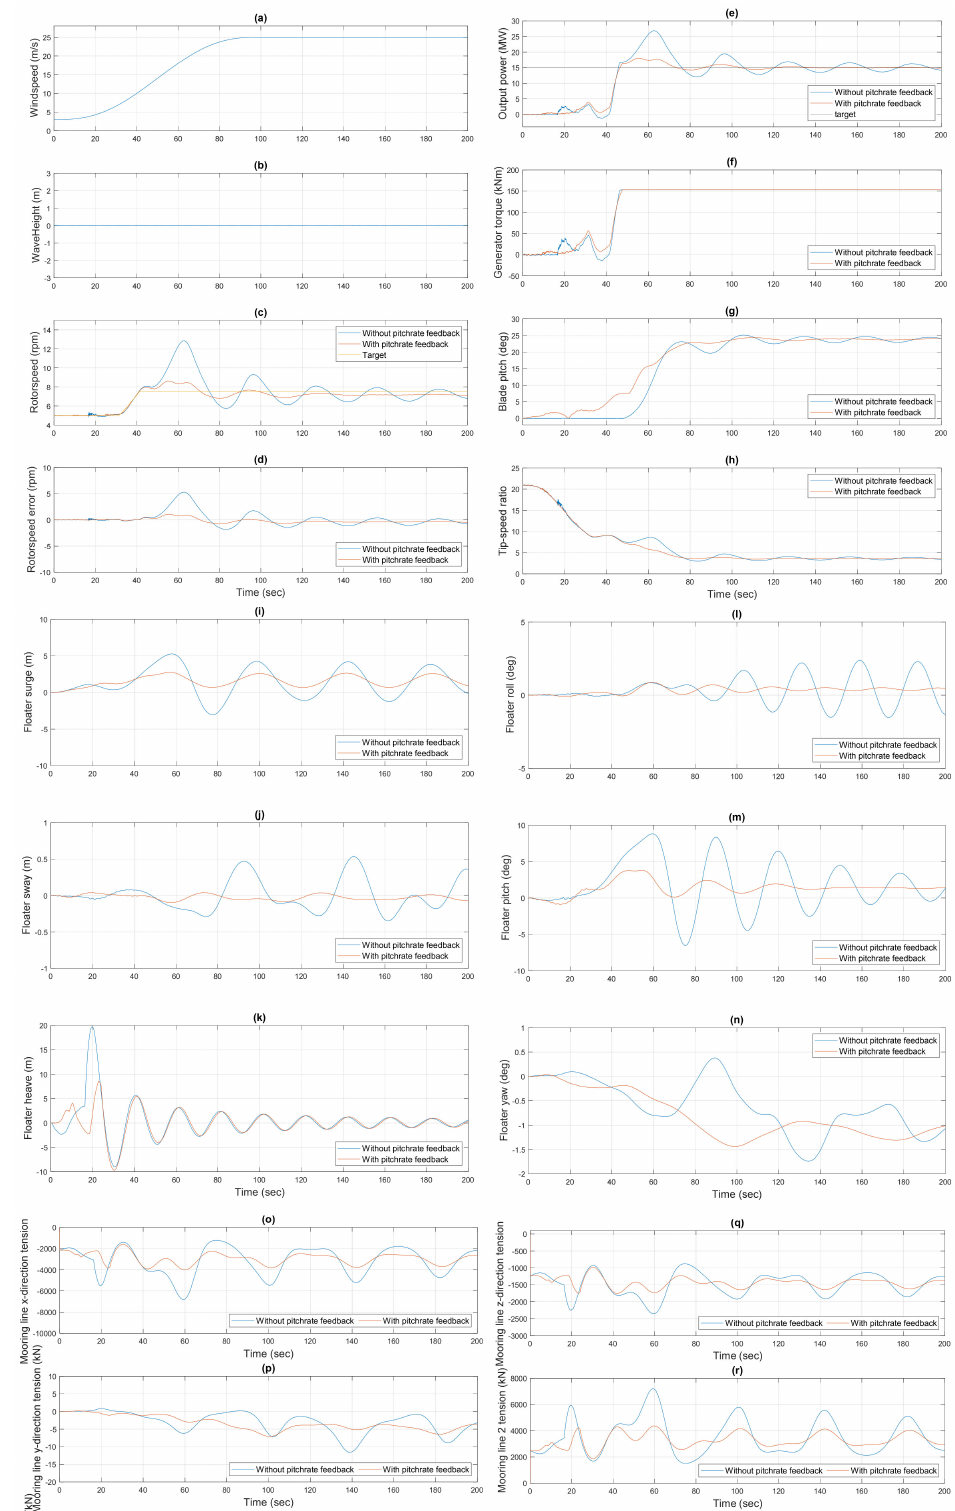
Figure 13. Simulation results of floating wind turbine with wind speed from 0 to 25 m/s and no wave by FSMC: ( a ) wind speed, ( b ) wave height, ( c ) rotor speed, ( d ) rotor-speed error, ( e ) output power, ( f ) generator torque, ( g ) blade-pitch, ( h ) tip-speed ratio, ( i ) floater surge, ( j ) floater sway, ( k ) floater heave, ( l ) floater roll, ( m ) floater pitch, ( n ) floater yaw, ( o ) mooring-line x-direction tension, ( p ) mooring-line y-direction tension, ( q ) mooring-line z-direction tension, ( r ) mooring-line